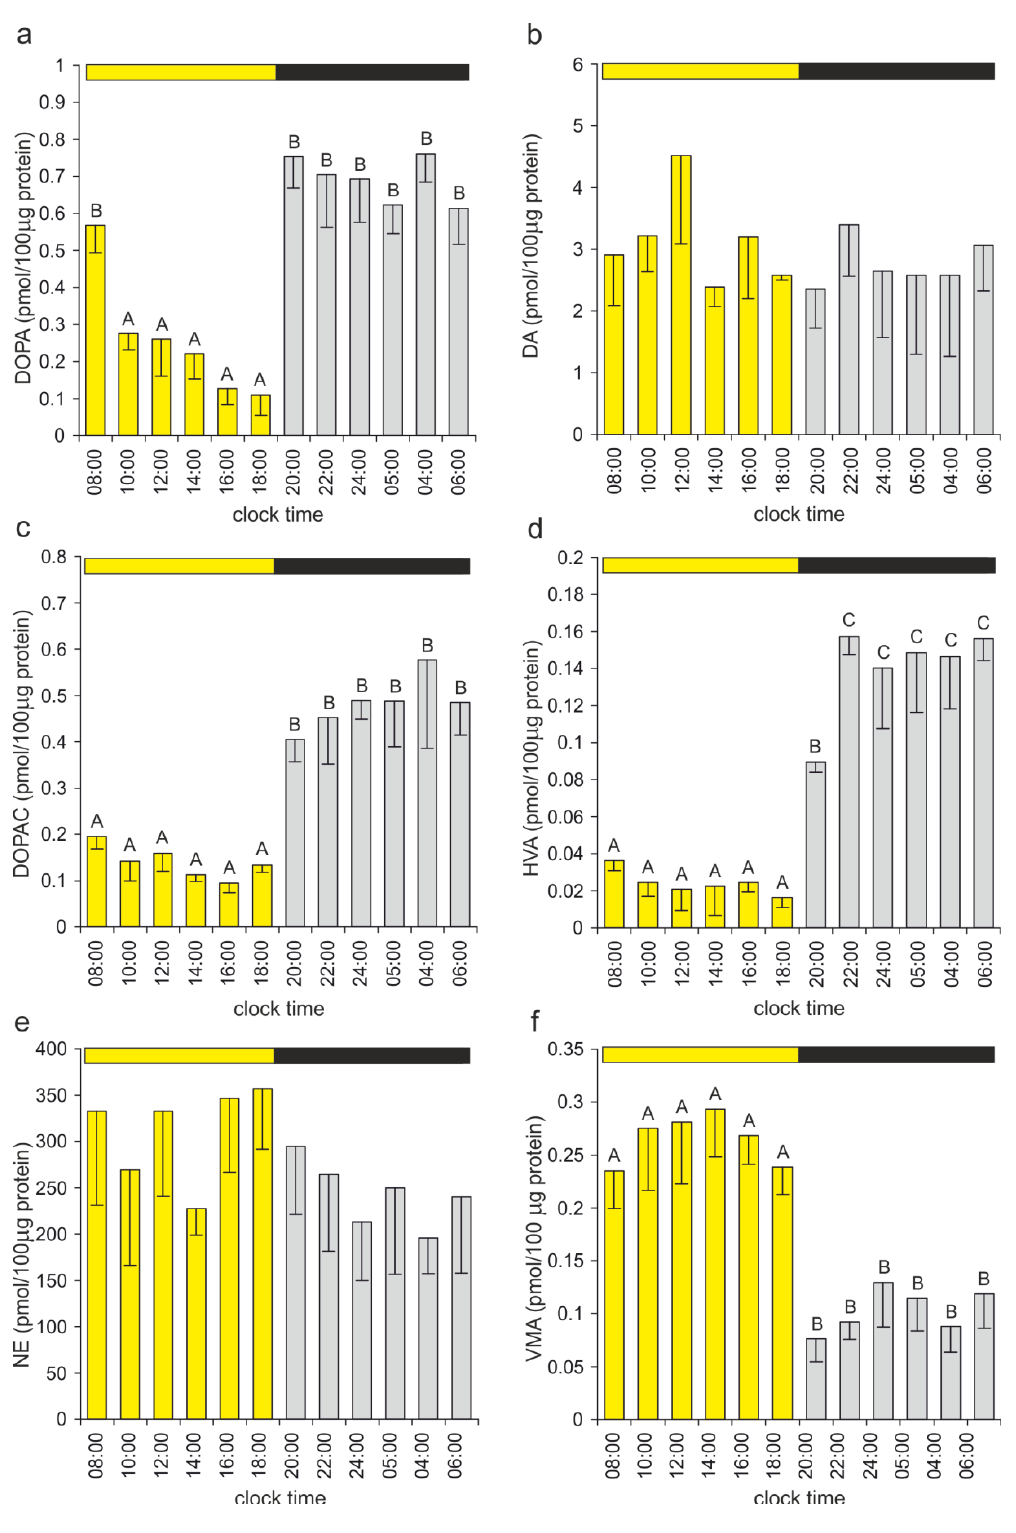
Figure 9. Catecholamines and their metabolites. ( a  f ) The DOPA, DA, DOPAC, HVA, NE and VMA contents in the duck pineal organs taken at two-hour intervals over a daily cycle (means and standard errors, n = 5). For explanations, see Figure